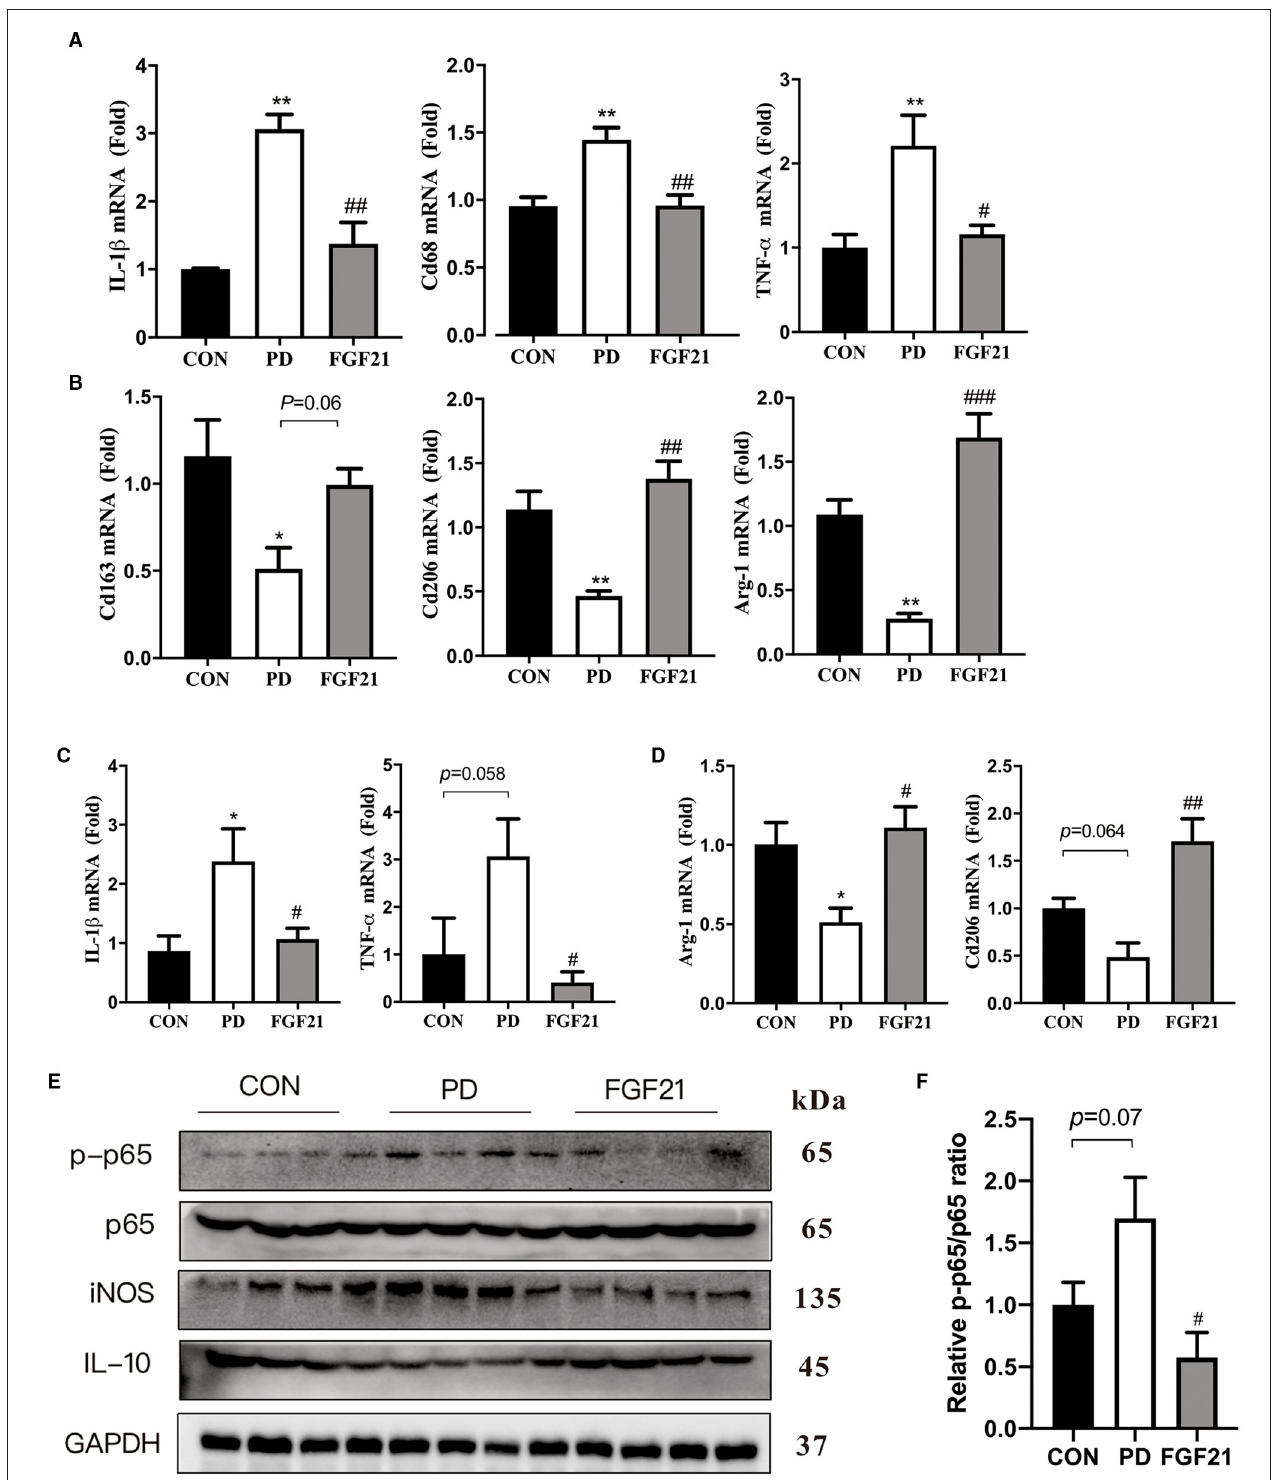
FIGURE 4 | FGF21 inhibited the nuclear factor-kappa B (NF- κ B) pathway and promotes M2 phenotypic transformation in the midbrain and striatum of mice with PD. qPCR analysis of microglial activation markers. M1 and M2 microglial genes in midbrain (A,B) . M1 and M2 microglial genes in striatum (C,D) . Data are mean ± s.e.m, n = 4 for each group. (E) Representative immunoblots of phosphorylated protein (p-p65), p65, iNOS, IL-10, and GAPDH in the ventral midbrain of CON, PD, and FGF21 mice. (F) Quantification of sirtuin 1 (SIRT1) and p-p65 levels in the ventral midbrain. Data are mean ± s.e.m, n = 4 for each group. A one-way ANOVA analysis was conducted followed by an LSD multiple comparison test. * P < 0.05, ** P < 0.01 vs. CON group; # P < 0.05, ## P < 0.01, ### P < 0.001 vs. MPTP-injected mice.